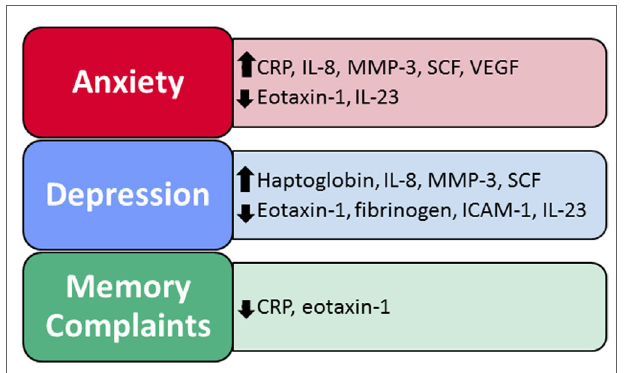
FigUre 1 | immune factors predict self-reported anxiety, depression, and memory problems . Two to eight immune factors were significant predictors of neuropsychiatric function within each of the regression models, for a total of 10 significant immune factors across all